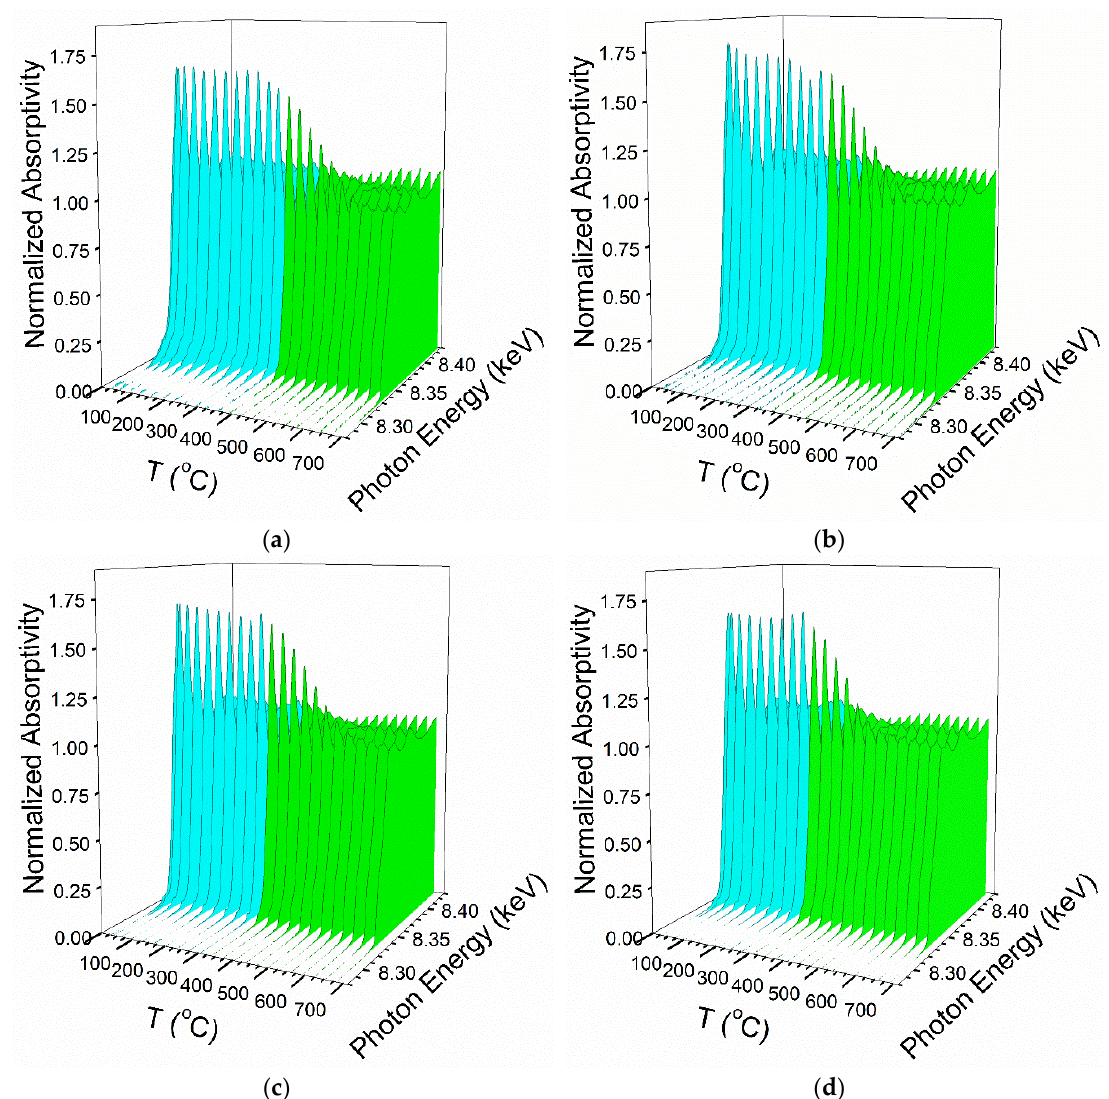
Figure 11. H 2 -TPR-XANES spectra at the Ni K-edges of ( a ) 25%M (M = 5%Ni-95%Co) / Al 2 O 3 , ( b ) 25%M (M = 10%Ni-90%Co) / Al 2 O 3 , ( c ) 25%M (M = 25%Ni-75%Co) / Al 2 O 3 , and ( d ) 25%M (M = 50%Ni-50%Co) / Al 2 O 3 . (Cyan) is Ni 2 + (e.g., NiO) associated with cobalt oxides during reduction of Co 3 O 4 to CoO. (Green) is reduction of Ni 2 + to Ni 0 when NiO reduction is associated with CoO reduction to Co 0 .